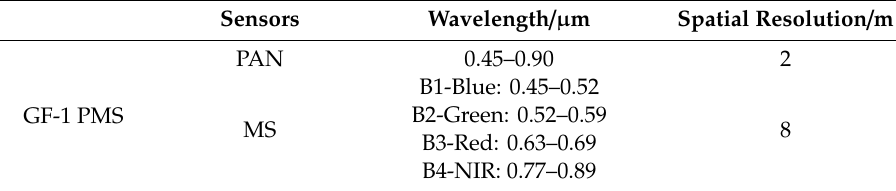
Table 2. Characteristics of GF-1 PMS